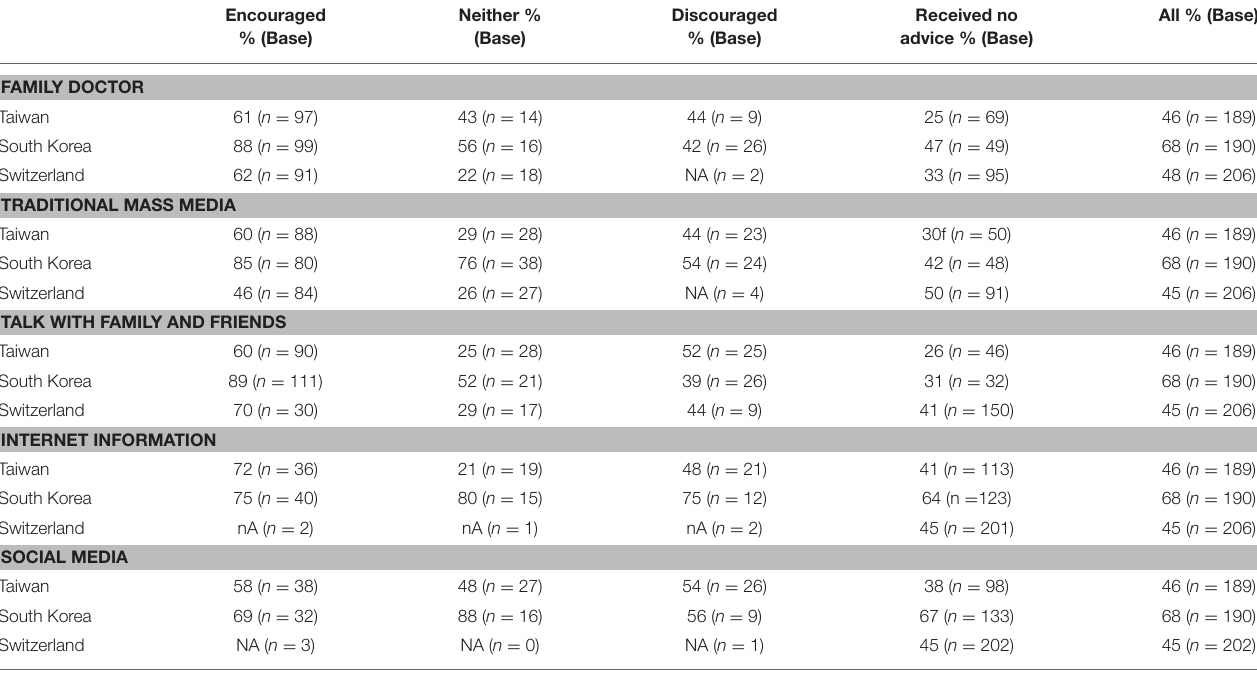
The rationale of data presentation is similar to Table 1 .